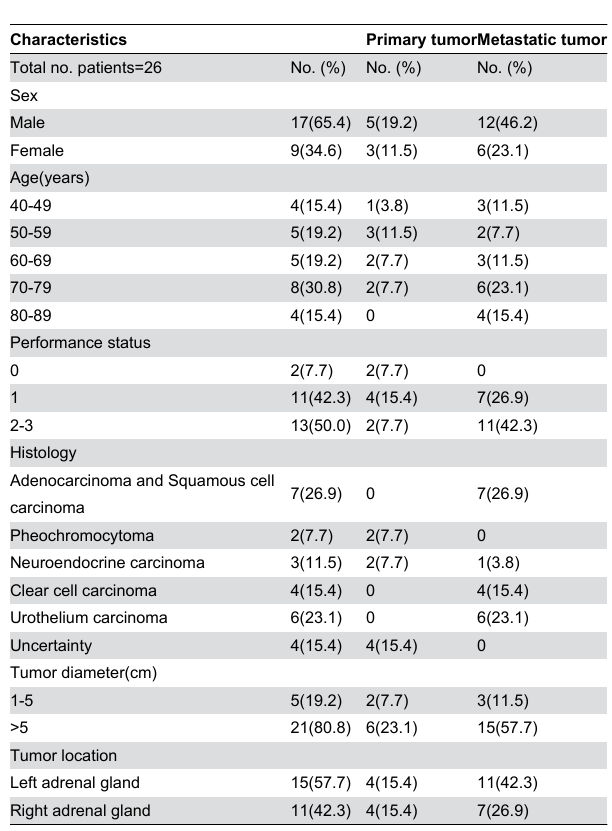
Table 3. Outcome and death of cyberkinfe for 26 patients with adrenal